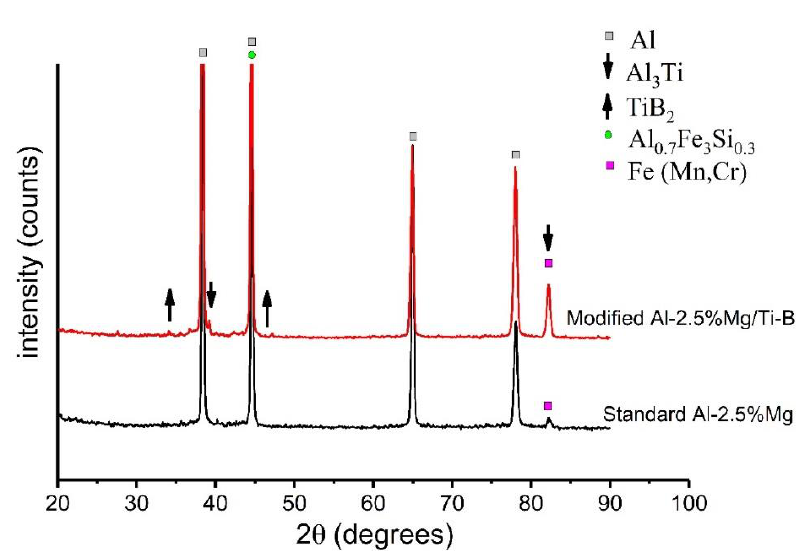
Figure 6. XRD analysis of the investigated alloys.